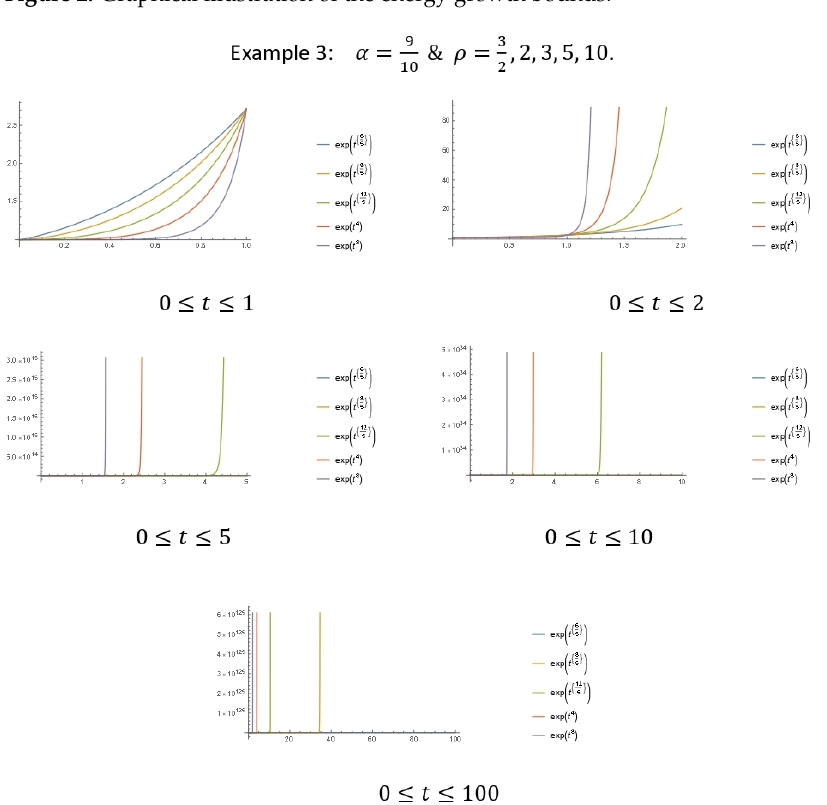
Figure 3. Graphical illustration of the energy growth